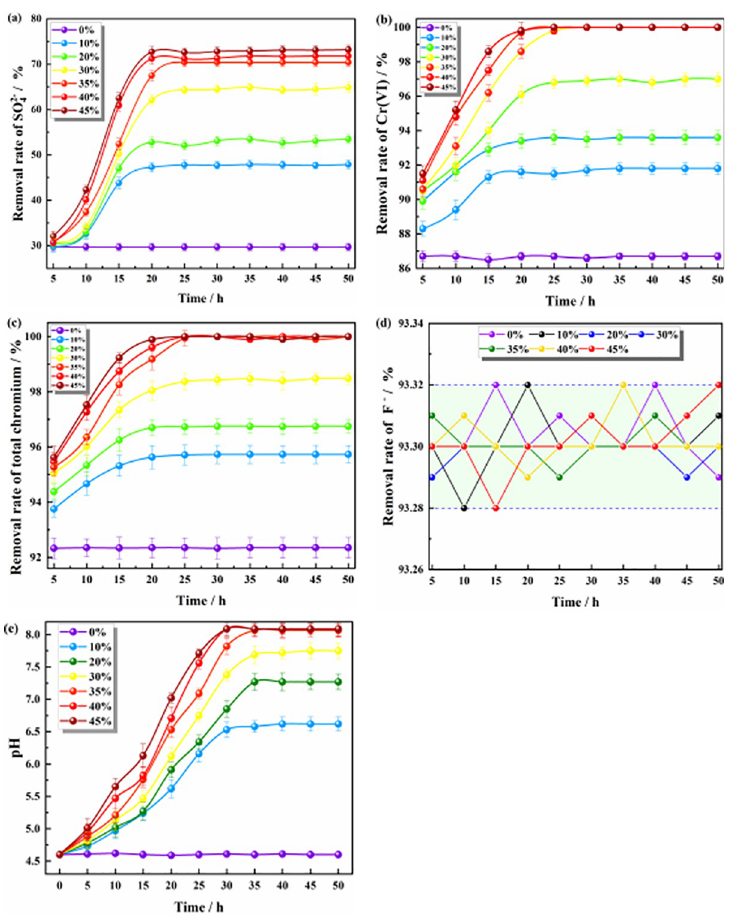
Fig 3. Effect of the dosage of Citrobacter on the removal of pollutants. (a) The effect on the removal of SO 42- ; (b) The effect on the removal of Cr(VI); (c) The effect on the removal of total chromium; (d) The effect on the removal of F - ; (e) The effect on pH